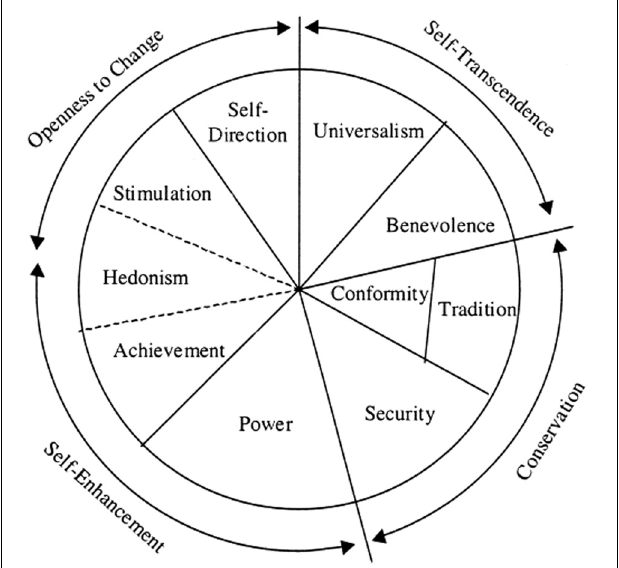
FIGURE 1 | Circumplex formed by the 10 universal core values (illustration reproduced with permission from Olver and Mooradian,